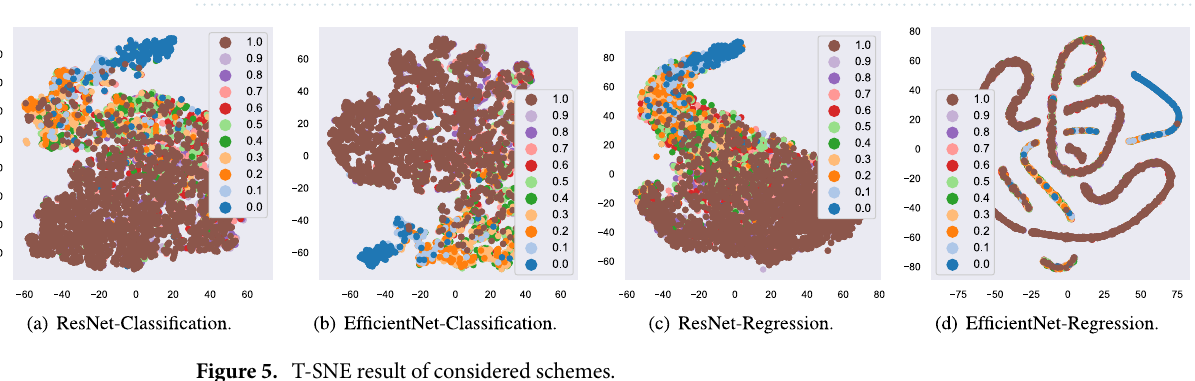
Figure 4. Wrong prediction result of the considered scheme when actual BCVA areis 0.0, 0.2, 0.4, 0.6, 0.8, and 1.0. The actual and predicted BCVA is indicated at the top of the figure.